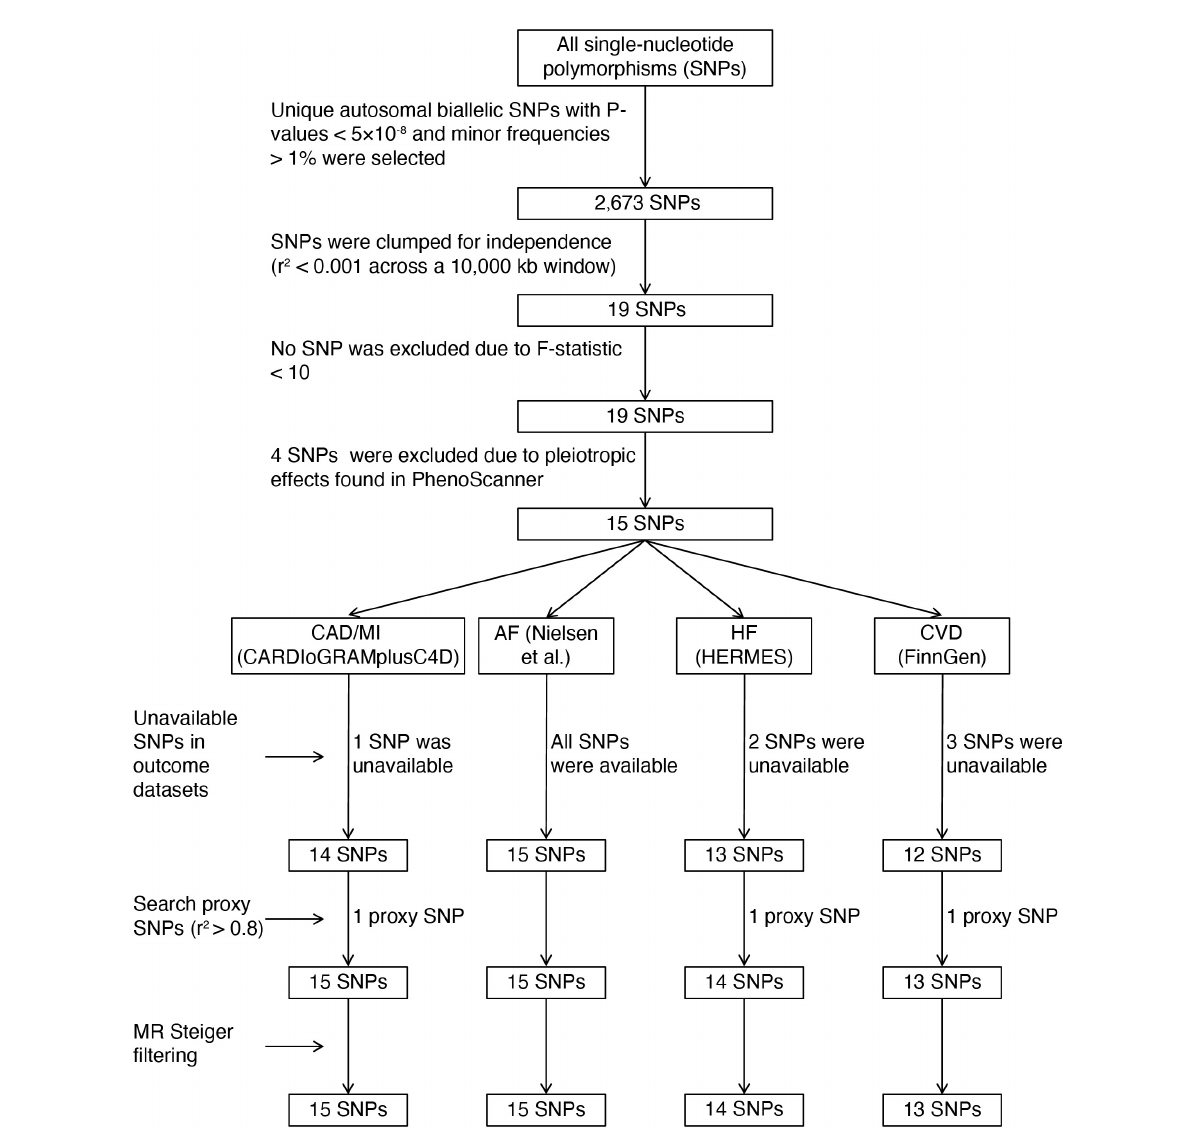
FIGURE2 The flowchart of instrumental variables selection. CAD, coronary artery disease; MI, myocardial infarction; AF, atrial fibrillation; HF, heart failure; CVD, cardiovascular diseases; CARDIoGRAMplusC4D, Coronary ARtery DIsease Genome-wide Replication and Meta-analysis (CARDIoGRAM) plus The Coronary Artery Disease (C4D) Genetics; HERMES, Heart Failure Molecular Epidemiology for Therapeutic